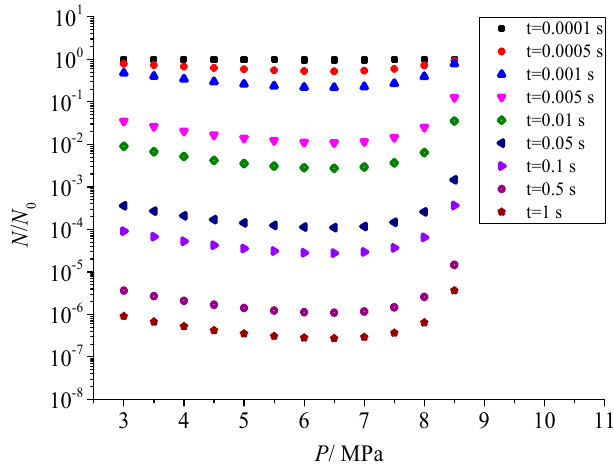
Figure 10. Effect of pressure on the total number of dimensionless particles.